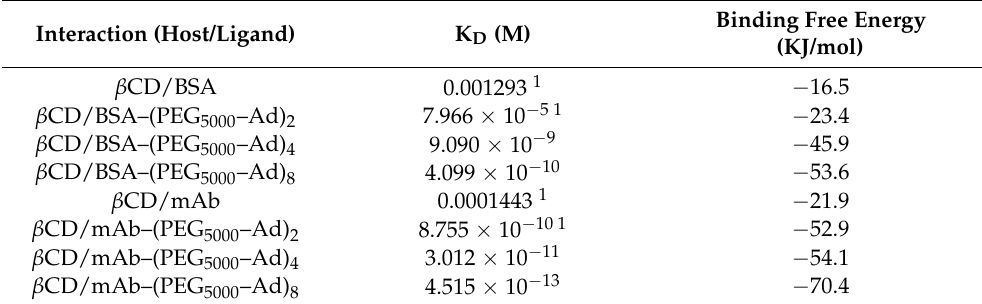
Table 1. SPR kinetics results for unmodified and modified protein–polymer conjugates against β -CD immobilized CM5 chip, diH 2 O running buffer.